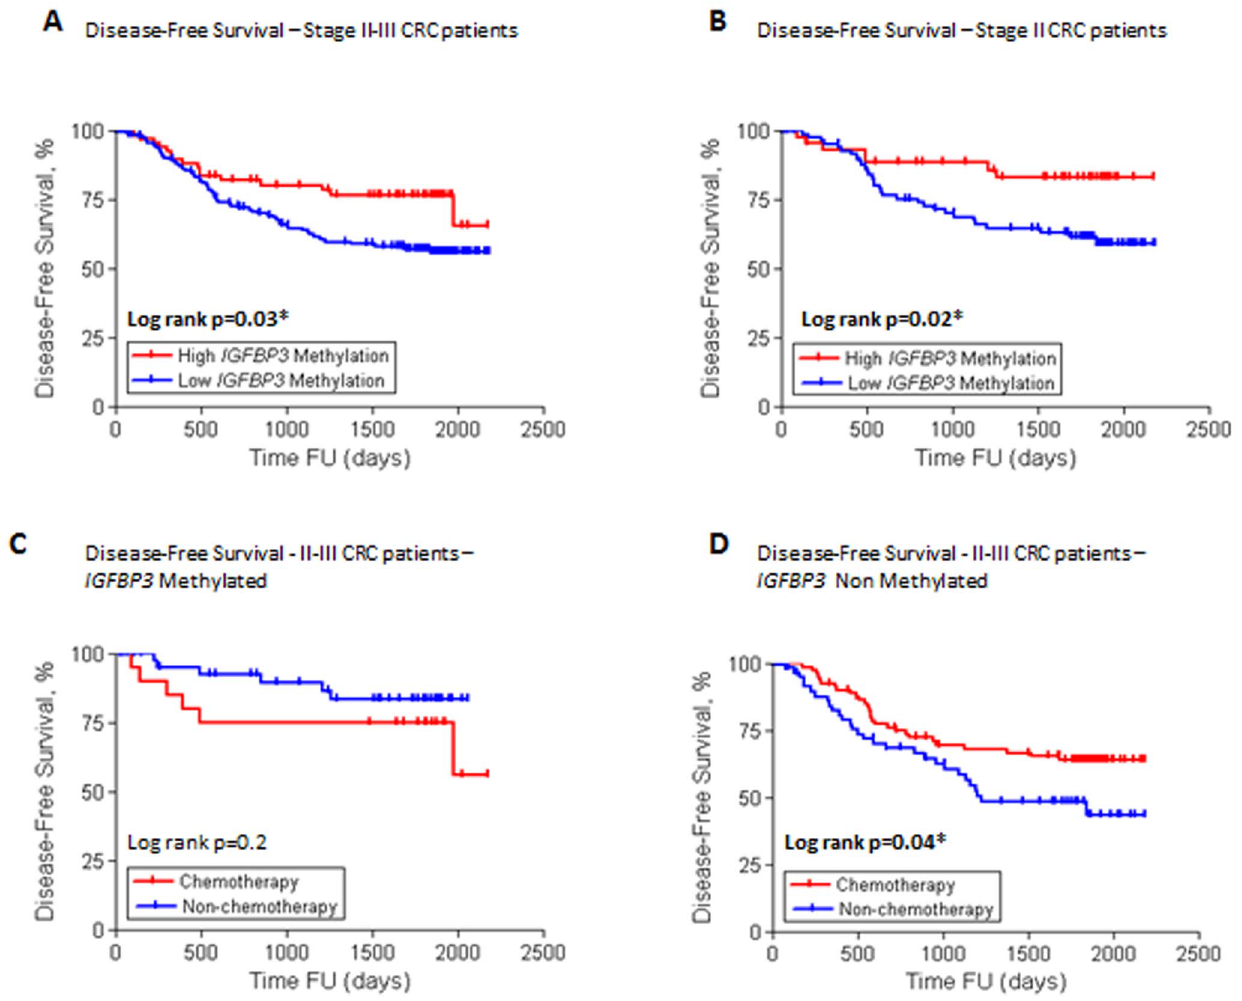
Figure 5. Relationship between igfbp3 methylation and prognostic and predictive response in stage ii and iii crc patients. (a) Disease-free survival of patients with stage ii and iii crc, according to igfbp3 methylation status (high methylation, n=73, (30.3%) low methylation, n=168, (69.7%). (b) Disease-free survival of patients with stage ii disease, according to igfbp3 methylation (high methylation, n=45, (32.4%); low methylation, n=94, (67.6%). (c) Disease-free survival of patients with stage ii and iii disease, in high igfbp3 methylation tumors based on adjuvant chemotherapy (chemotherapy, n=20, (22.5%); no chemotherapy, n=69, (77.5%). (d) Disease-free survival of patients with stage ii and iii disease, in low igfbp3 methylation tumors according to adjuvant chemotherapy (Chemotherapyc n=83, (52.7%); NO Chemotherapy, n=74,